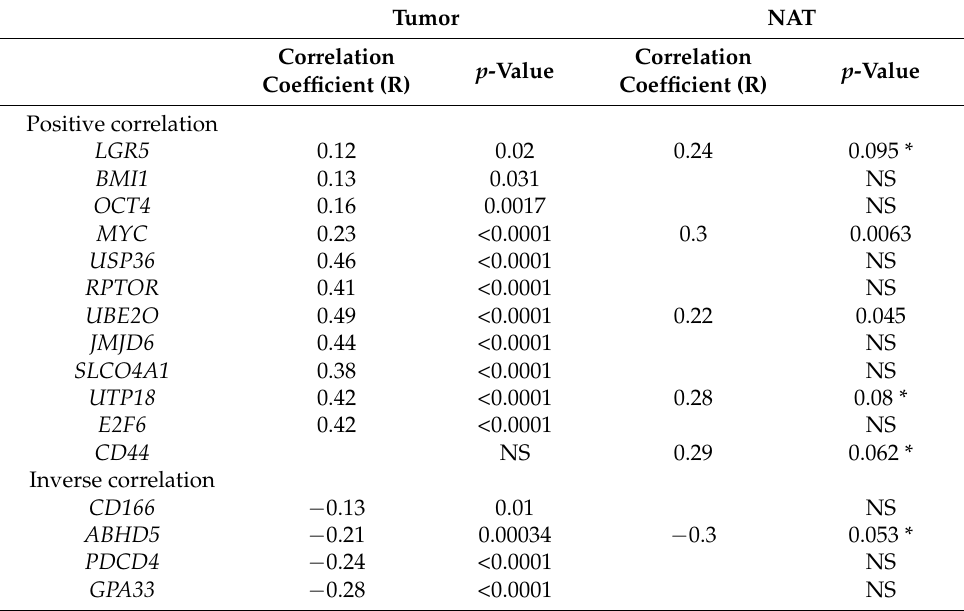
Table 2. Correlation between expression of CBX8 and pluripotency-associated genes in CRC and NAT specimens from the TCGA